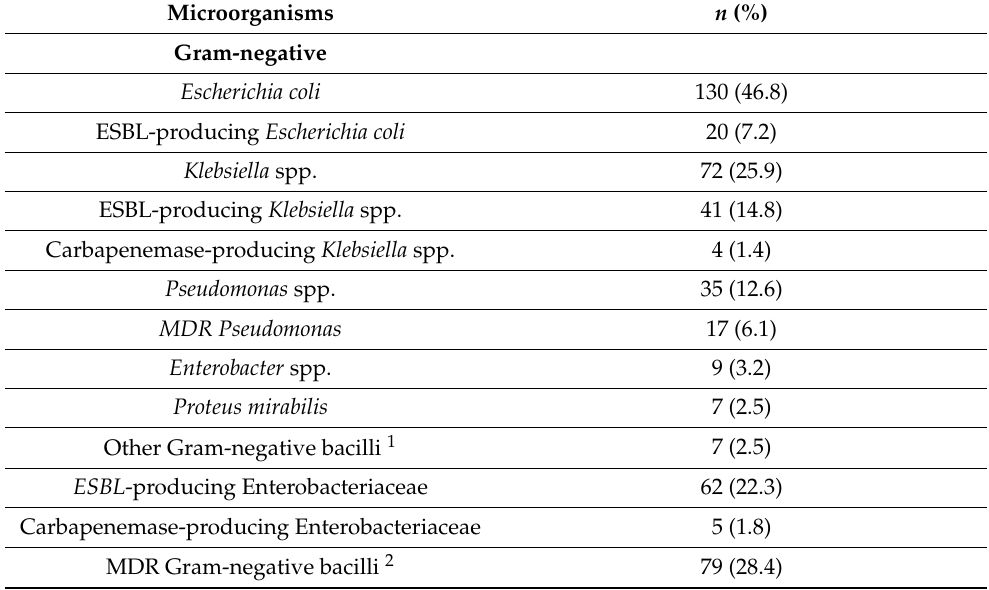
Table 2. Causative microorganisms of 278 episodes of acute graft pyelonephritis with bacteremia in 214 KT